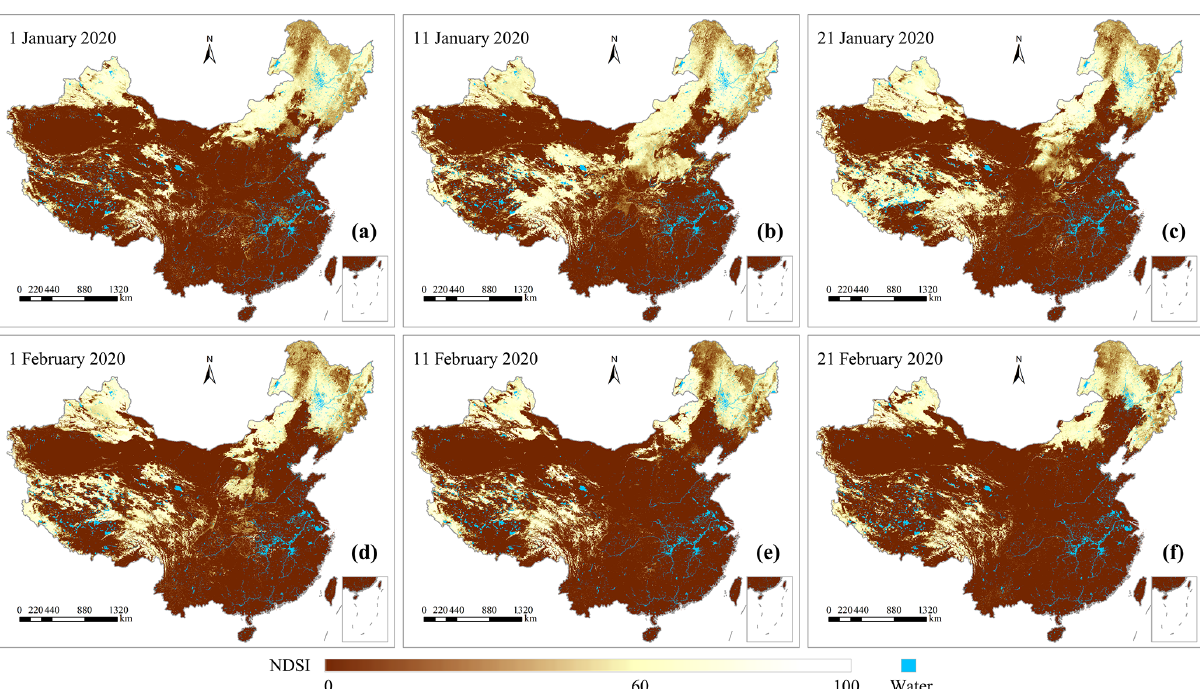
Figure 8. A sequence of the STAR NDSI collection from 1 January 2020 to 21 February 2020.